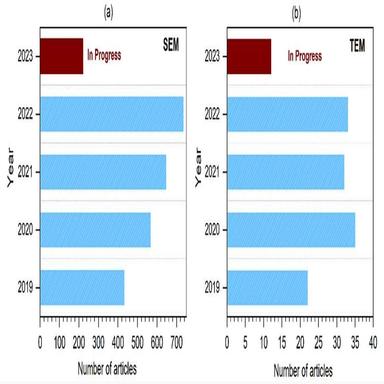
Number of articles published in the past four years that applied SEM (a) or TEM (b) to characterize cement-based materials. The results were obtained from a Scopus database search in May 2023, for (SEM) AND (cement) in the title, keywords, or abstract for (a) and (TEM) AND (cement) in the title, keywords, or abstract for (b).